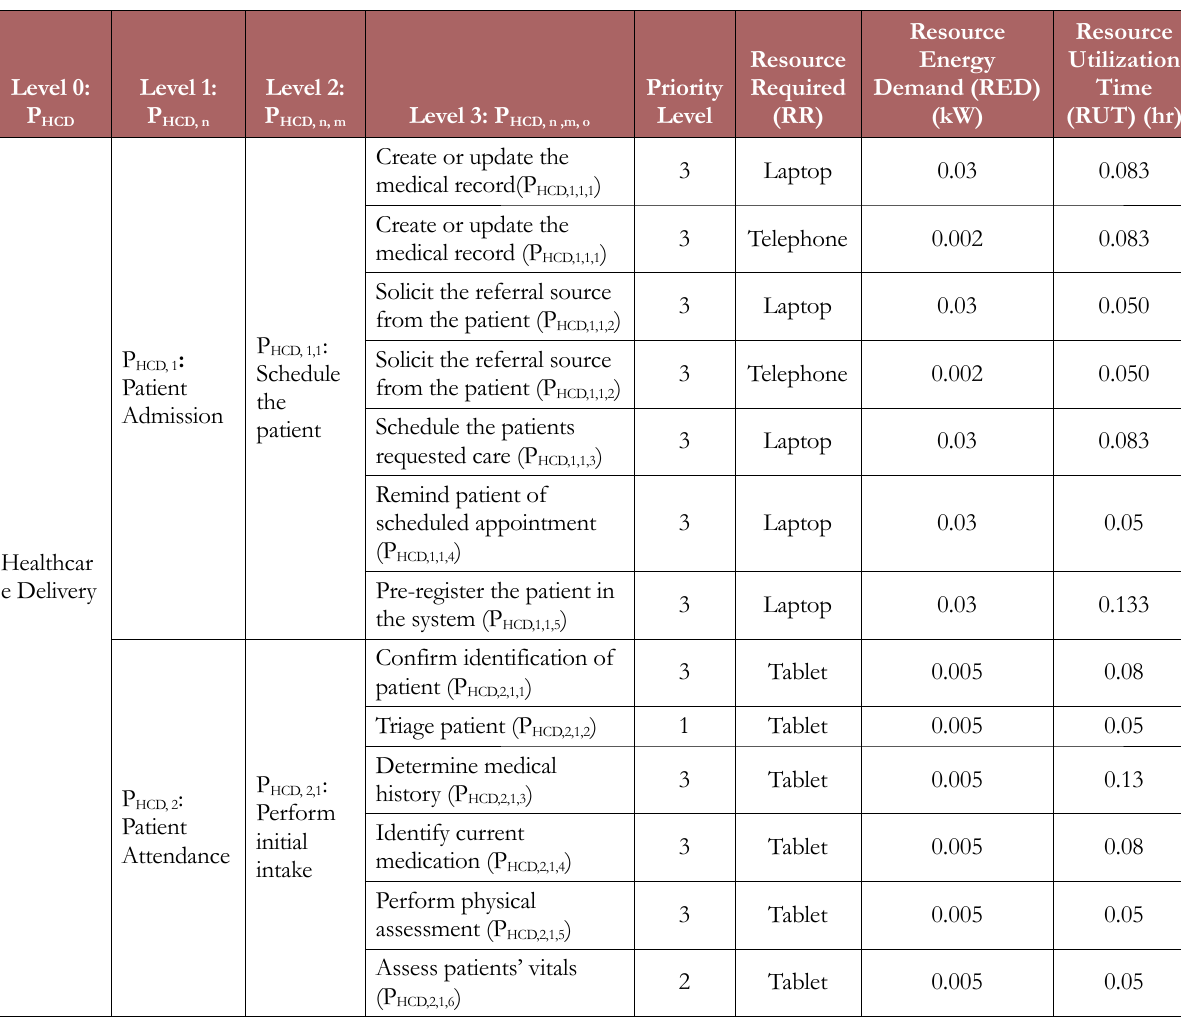
Table 1. Business process hierarchy with details the resource required, resource energy demand and resource utilization time